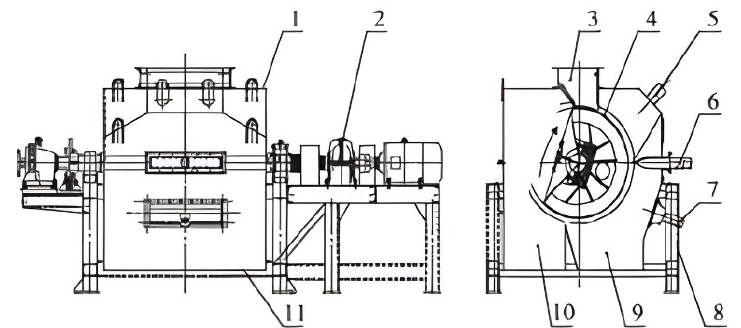
Figure 11. Powder ore wind-driven dry magnetic separator [46]: 1—upper shell; 2—transmission device; 3—ore feeding port; 4—magnetic roller; 5—dust removal port; 6—air inlet device; 7—wind compensation device; 8—frame; 9—tailings mouth; 10—concentrate mouth; 11—the shell.